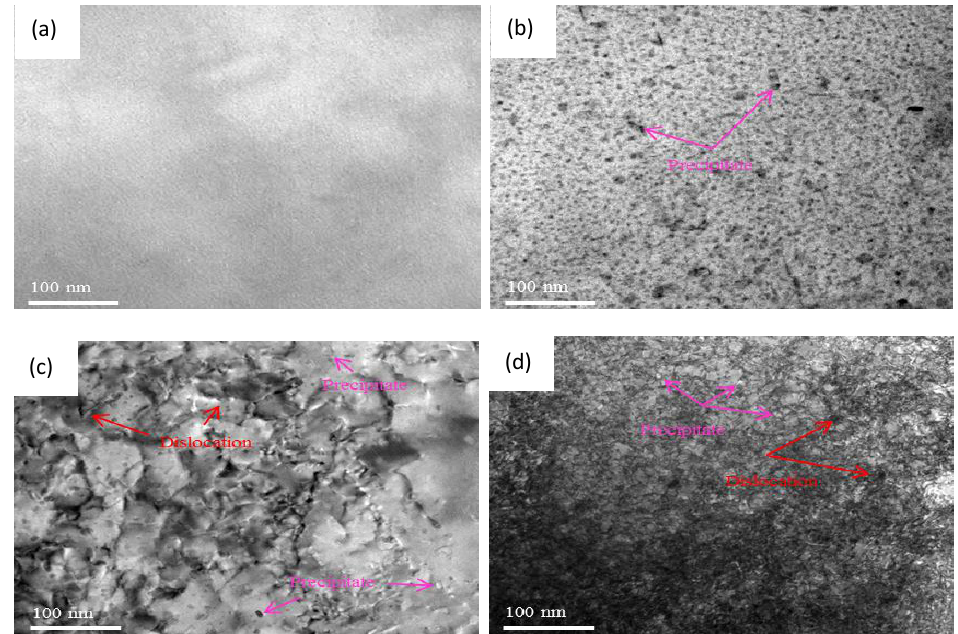
Figure 6. Initial microstructures of the un-stretched alloys with different states of ( a ) solutionizing; ( b ) T6; and TEM micrographs of the alloys treated by T6 before conducting creep-aging tests with various pre-stretching conditions of ( c ) 1.7% and ( d ) 6.7%.